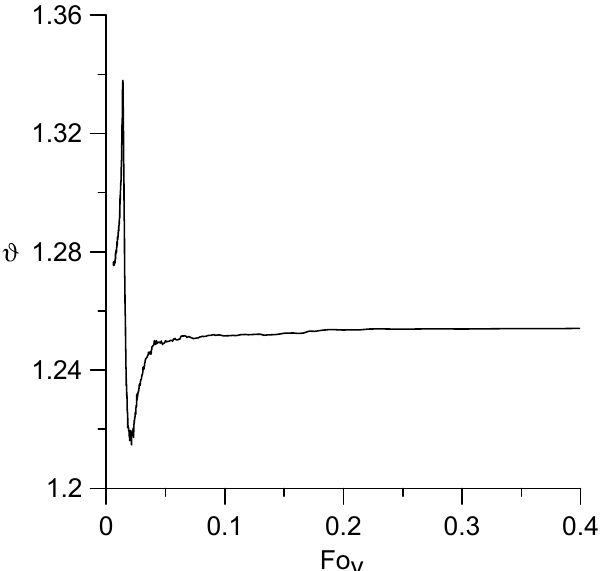
Figure 11. The local temperature ϑ as function of Fourier number corresponding to the flow rate of the substance v 0 at the point ξ = 0.8, θ = 0°, ζ = 0.5 for Fo = 0.5, φ 0 = 73.68°, ω = 0.292 Hz (Fo 0 = 0.0135) and R 2 = 0.009 m.